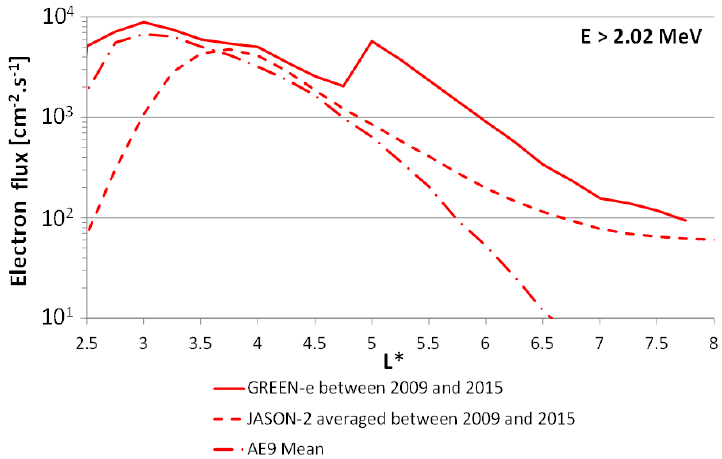
Figure 17. Mean electron fluxes in Jason-2 orbit between 2009 and 2015 from GREEN- e (in full line), Jason-2 measurements (in dashed line) and AE9 mean v1.5 (dash-dotted line) for E >2.02MeV